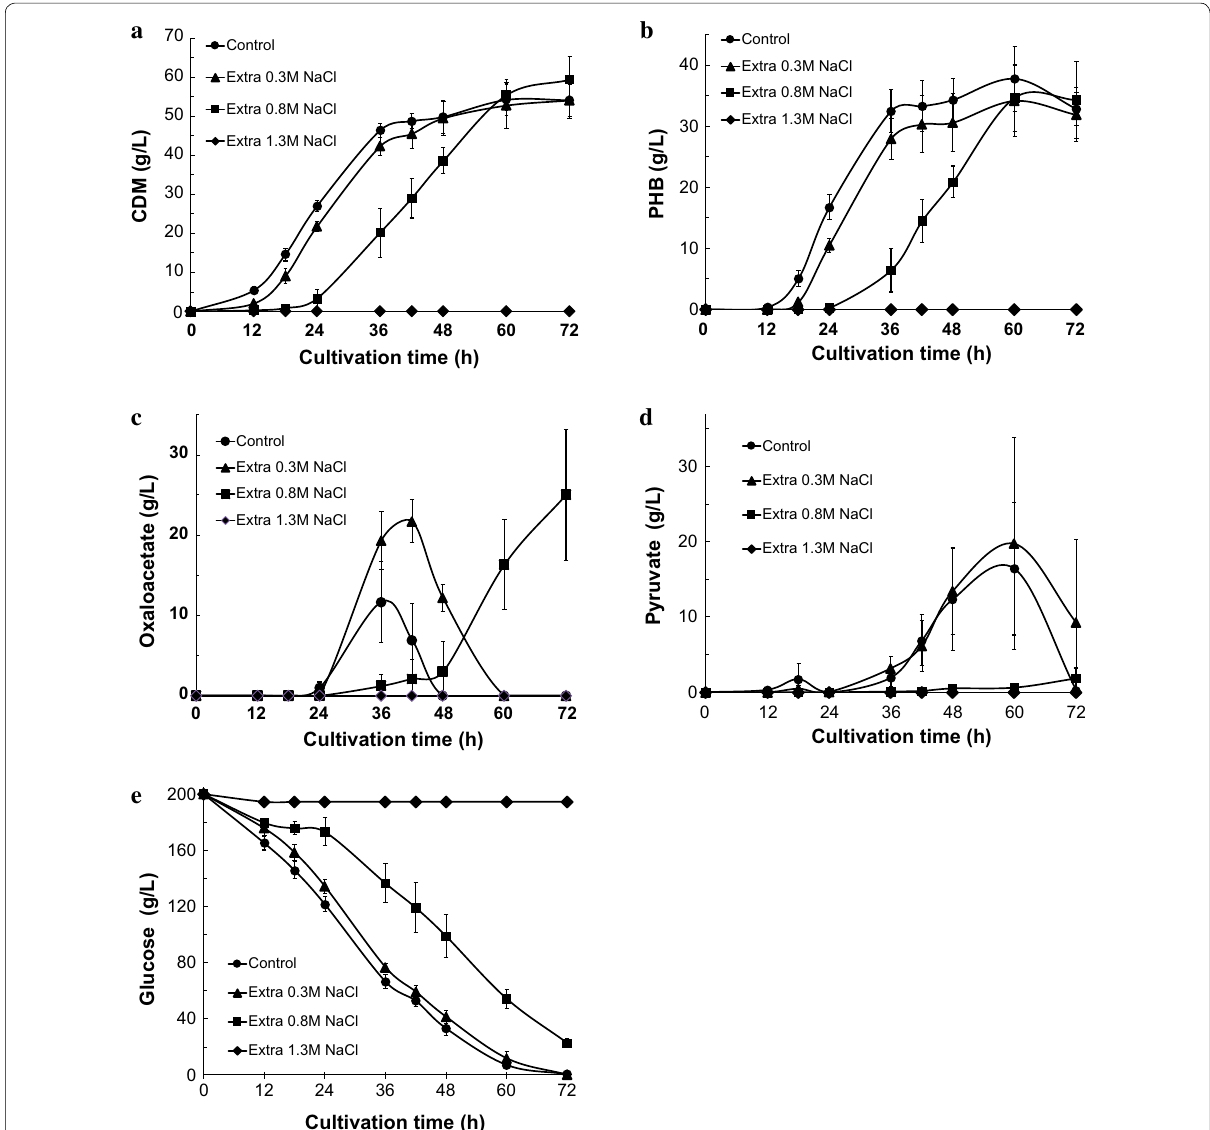
Fig. 1 Oxaloacetate, pyruvate, and bioplastic poly-( R )-3-hydroxybutyric acid production by Halomonas sp. KM-1 with different NaCl concentrations. KM-1 cells were cultured under aerobic conditions (agitation speed: 200 rpm) at 37 °C. The medium was composed of modified SOT medium, with the control (circles), extra 0.3 M (triangles), extra 0.8 M (squares), or extra 1.3 M (diamonds) NaCl samples shown. a Cell dry mass (CDM), b intracellu- lar bioplastic poly-( R )-3-hydroxybutyric acid (PHB), c oxaloacetate, d pyruvate in the medium, and e glucose in the medium were analyzed. The data shown represent the mean SD of five independent ±